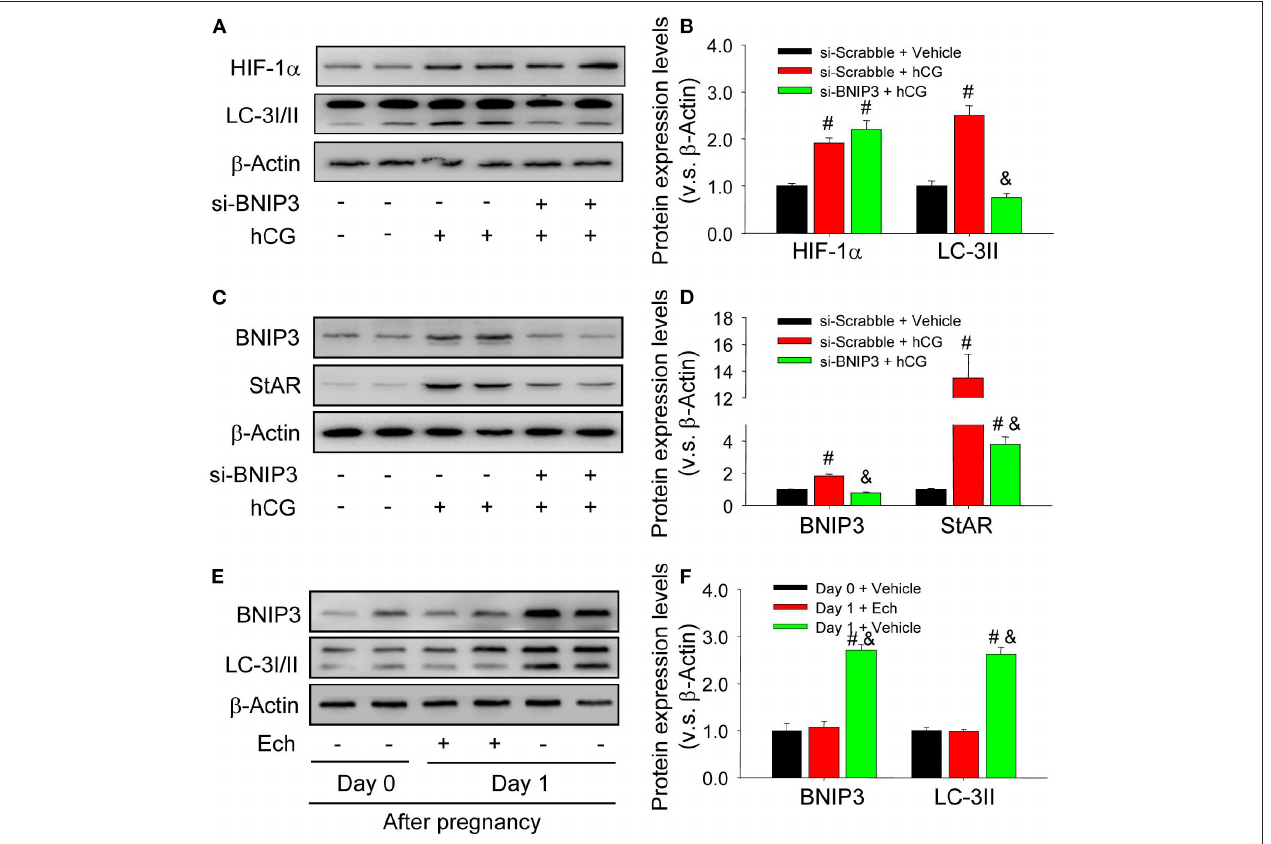
FIGURE 3 | Autophagy is regulated by HIF-1 α /BNIP3 pathway. (A) The expression changes of HIF-1 α and LC-3I/II in granulosa cells transfected with si- BNIP3 for 36h after hCG treatment. (B) Summarized intensities of HIF-1 α and LC-3I/II blotting normalized to the control (si-scrabble and vehicle). (C) The expression changes of BNIP3 and StAR in granulosa cells transfected with si- BNIP3 for 36h after hCG treatment. (D) Summarized intensities of BNIP3 and StAR blotting normalized to the control (si-scrabble and vehicle). (E) The expression changes of BNIP3 and LC-3I/II during the formation of corpus luteum after echinomycin treatment by Western blot. (F) Summarized intensities of BNIP3 and LC-3I/II bloting normalized to the control (Day 0). Each value represents the mean ± SE. One-way analysis of variance (ANOVA) was used to analyze the data, followed by a Tukey’s multiple range test. n = 6. si-scrabble, scrabble siRNA; si- BNIP3, siRNA targeting BNIP3; hCG, human chorionic gonadotropin; Ech, echinomycin, # P < 0.05, vs. the group in black; & P < 0.05, vs. the group in red.